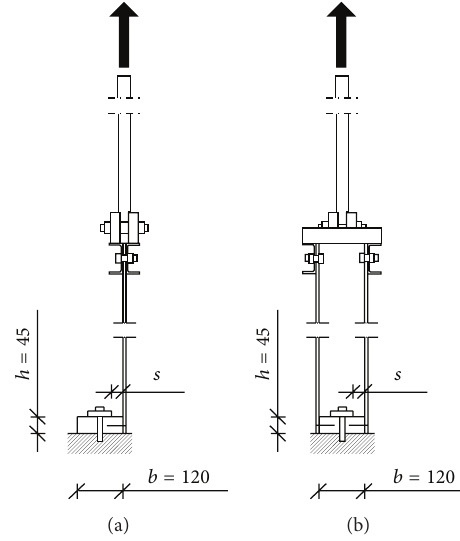
Figure 1: Cross section view of the specimen tested: (a) single-sided sheathing and (b) double-sided